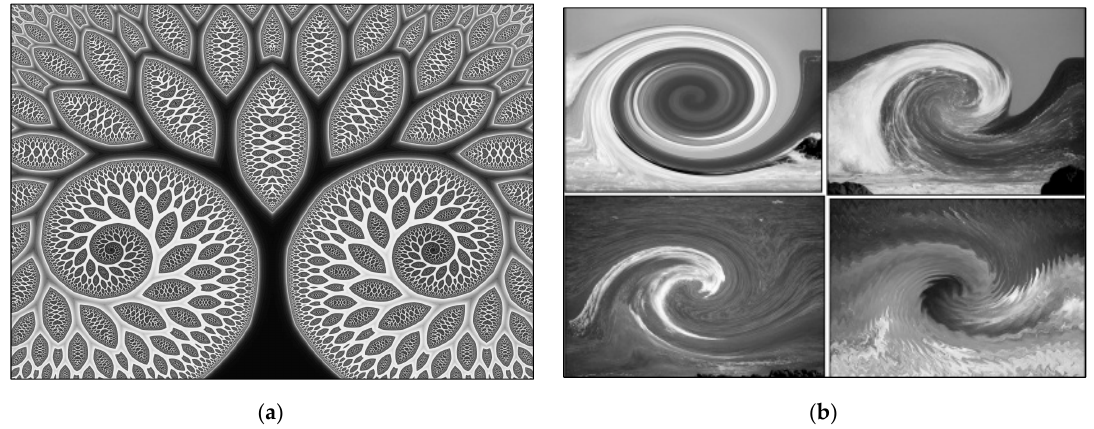
Figure 1. Examples of a fractal pattern ( a ) and an altered wave pattern ( b ) from